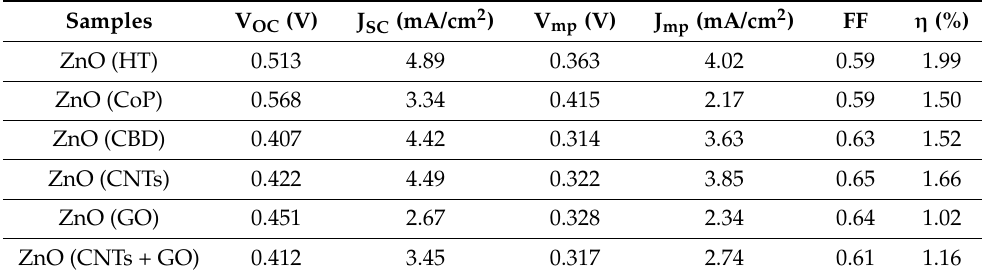
Table 3. Electrical parameters of